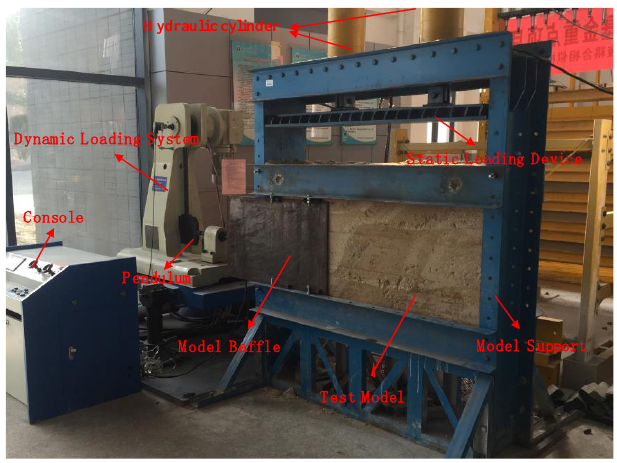
Figure 2. Similarity simulation test system.